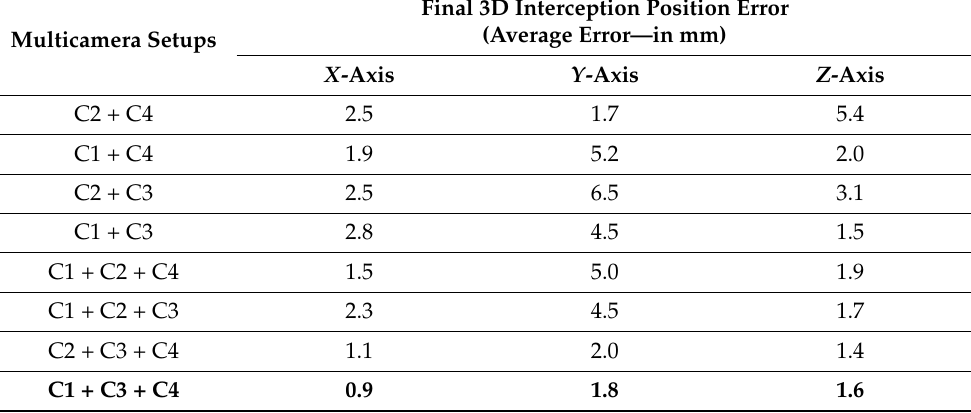
Table 2. Final touch point accuracy by different multi-camera setups (results based upon average of 50 real world